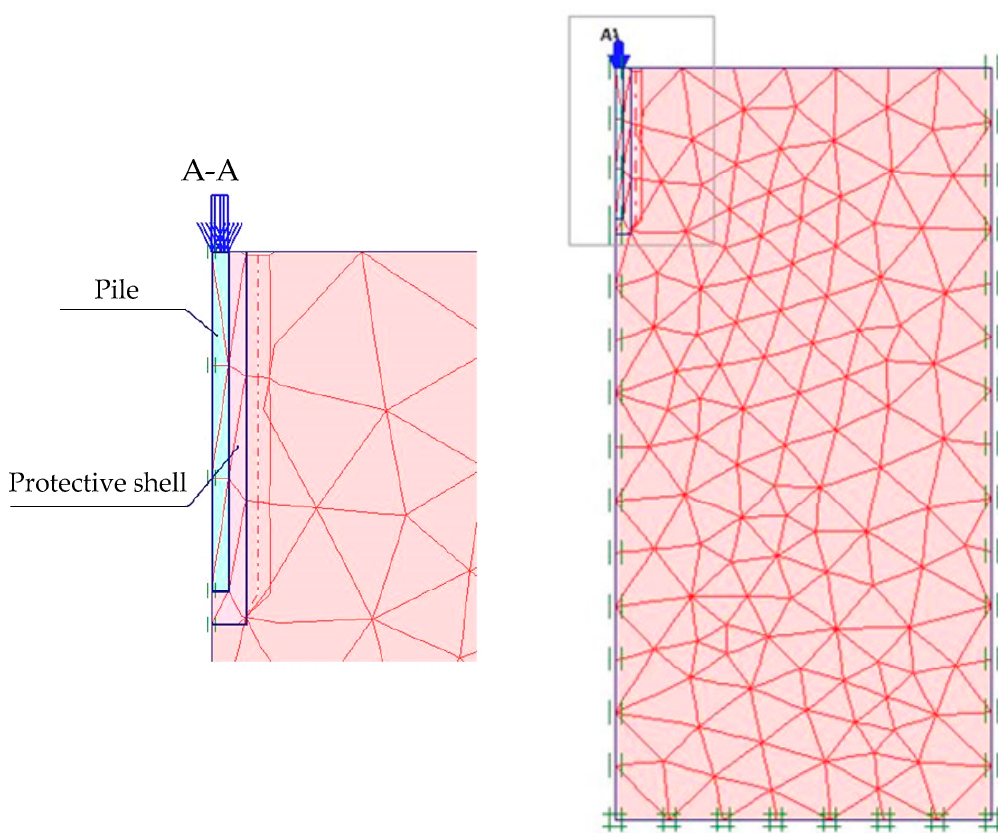
Figure 13. Geometric model of numerical simulation of a bored pile with a protective shell.